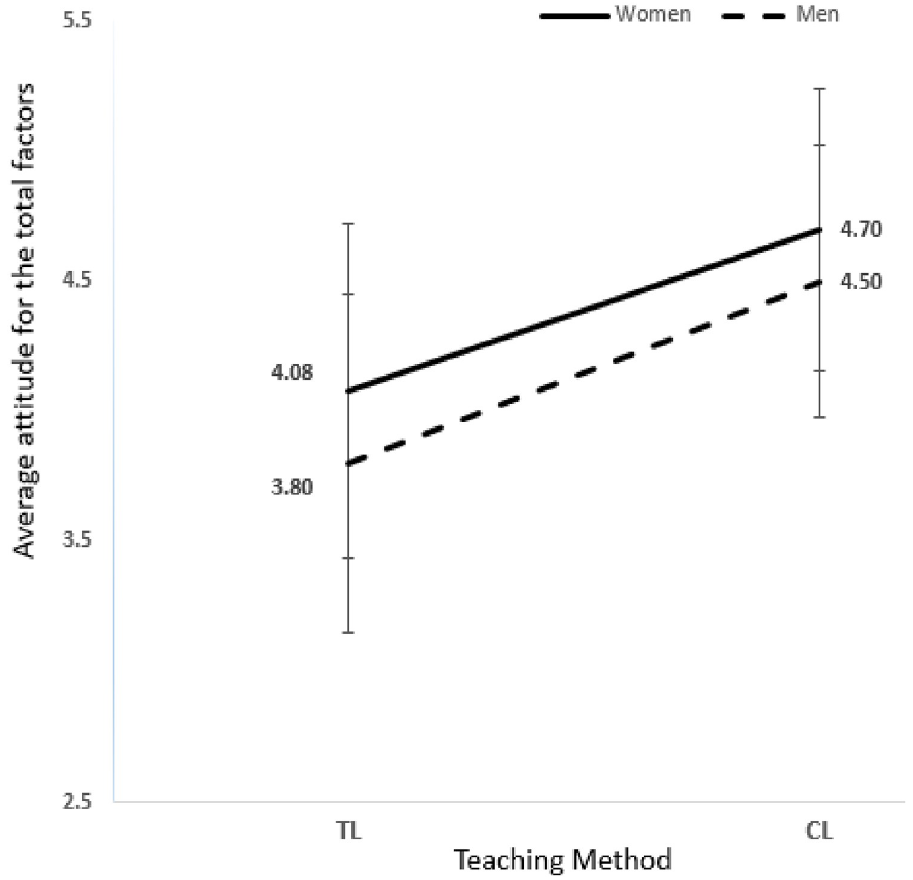
Fig 7. Major single-gender: Present the total nine attitude factors mean and SD for major single-gender students.